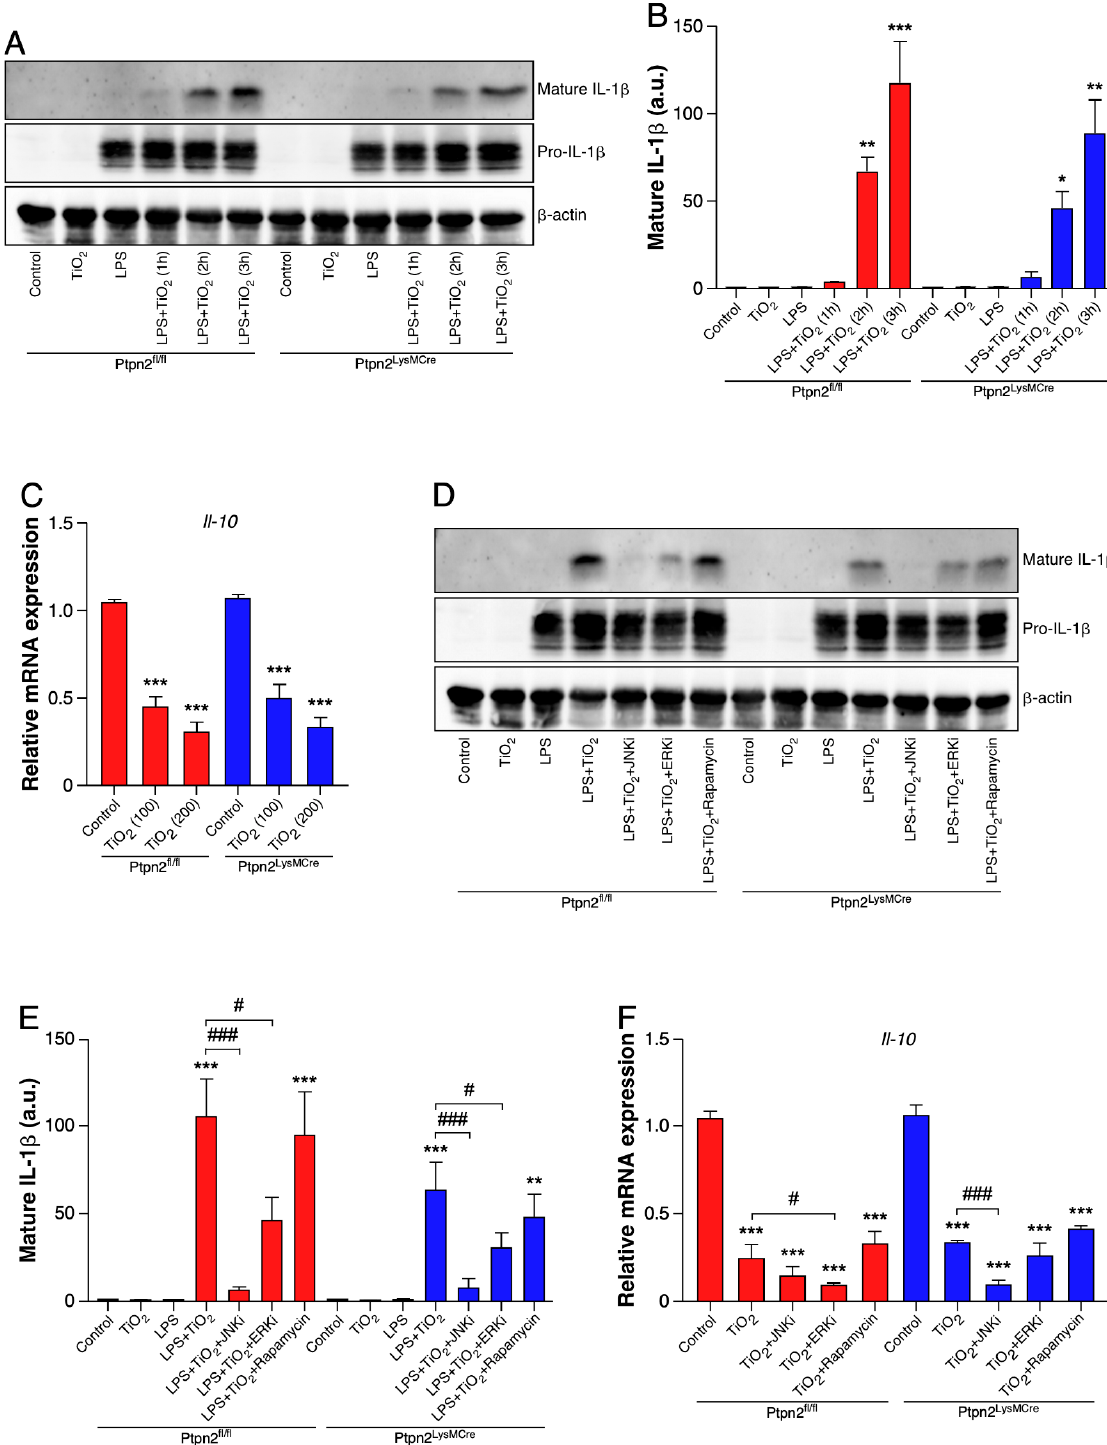
Figure 5. TiO 2 up-regulates IL-1 β and down-regulates IL-10 expression in BMDMs. ( A,B,D,E ), Representative Western blot images, showing the expression of the indicated proteins under the indicated treatments in BMDMs from Ptpn2 fl/fl and Ptpn2 LysMCre mice and the corresponding densitometric analysis expressed by arbitrary units (a.u.). ( C , F ) Levels of the indicated transcript under the indicated treatments in BMDMs from Ptpn2 fl/fl and Ptpn2 LysMCre mice. Data shown in panels ( B,C,E,F ) represent mean ± SEM. * p ≤ 0.05; ** p ≤ 0.01; *** p ≤ 0.001 relative to control of the same genotype. # p ≤ 0.05; ### p ≤ 0.001 relative to LPS+TiO 2 or TiO 2 of the same genotype. Results from three independent